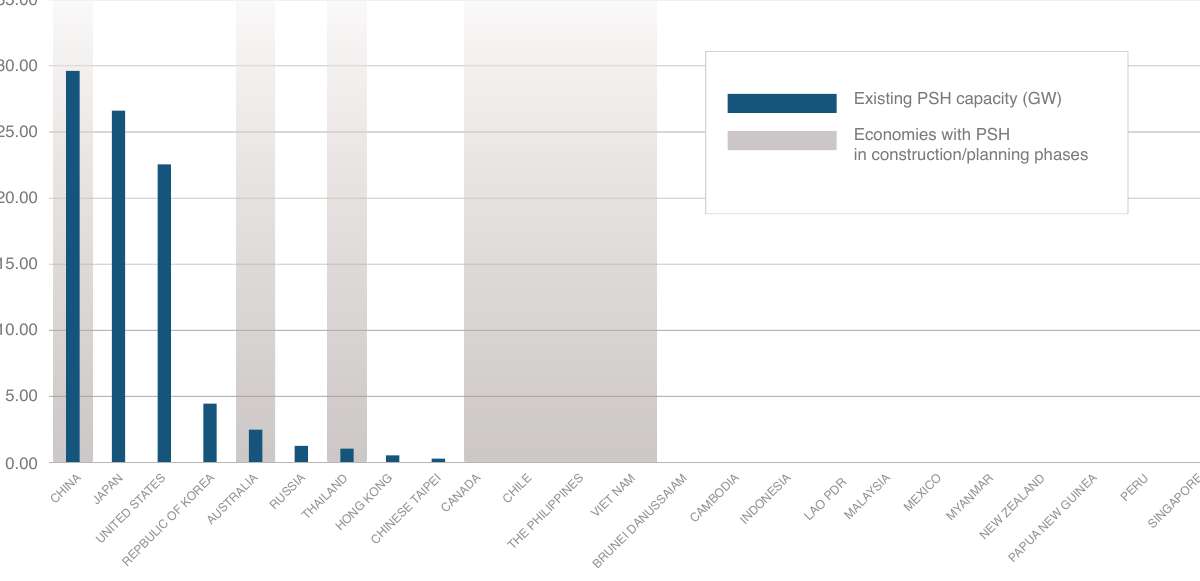
Figure 2. Existing PSH capacity (GW) plus economies with PSH in development (Source: